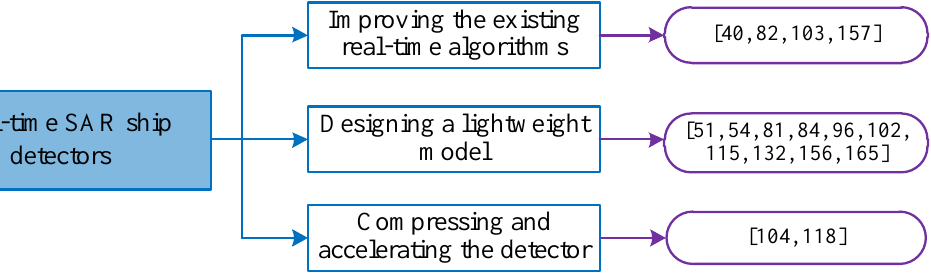
Figure 13. The real-time SAR ship detectors.